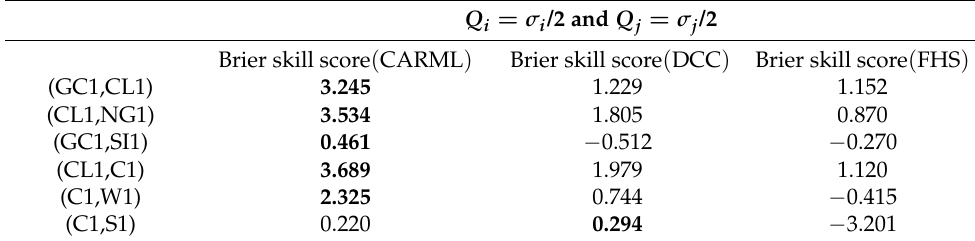
Table 3. Brier skill scores for the selected pairs of